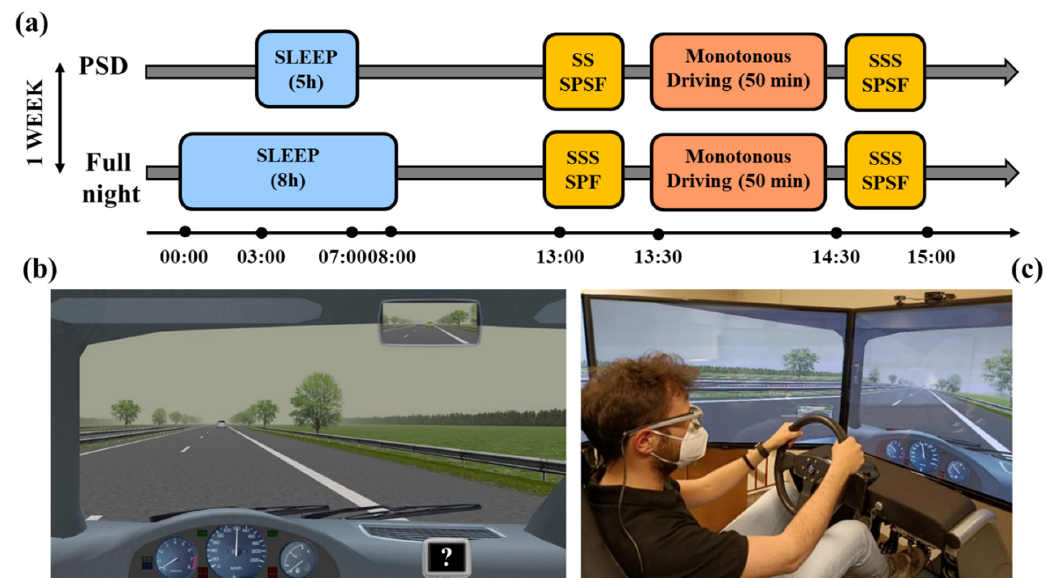
Figure 1. ( a ) Schematic representation of the experimental procedure. We used a within-subject design with all participants performing the study in two experimental conditions (full night of sleep and partial sleep deprivation) separated by one week. The order of the condition was counterbalanced across participants. ( b ) The driving scenario adopted for the experiments: Monotonous Environment. Note the question mark (?) on the dashboard monitor positioned on the lower-right part of the screen, which appeared every 9 min. ( c ) A participant driving in the dynamic simulator. PSD: partial sleep deprivation; SSS: Stanford Sleepiness Scale; SPF: Samn–Perelli Fatigue